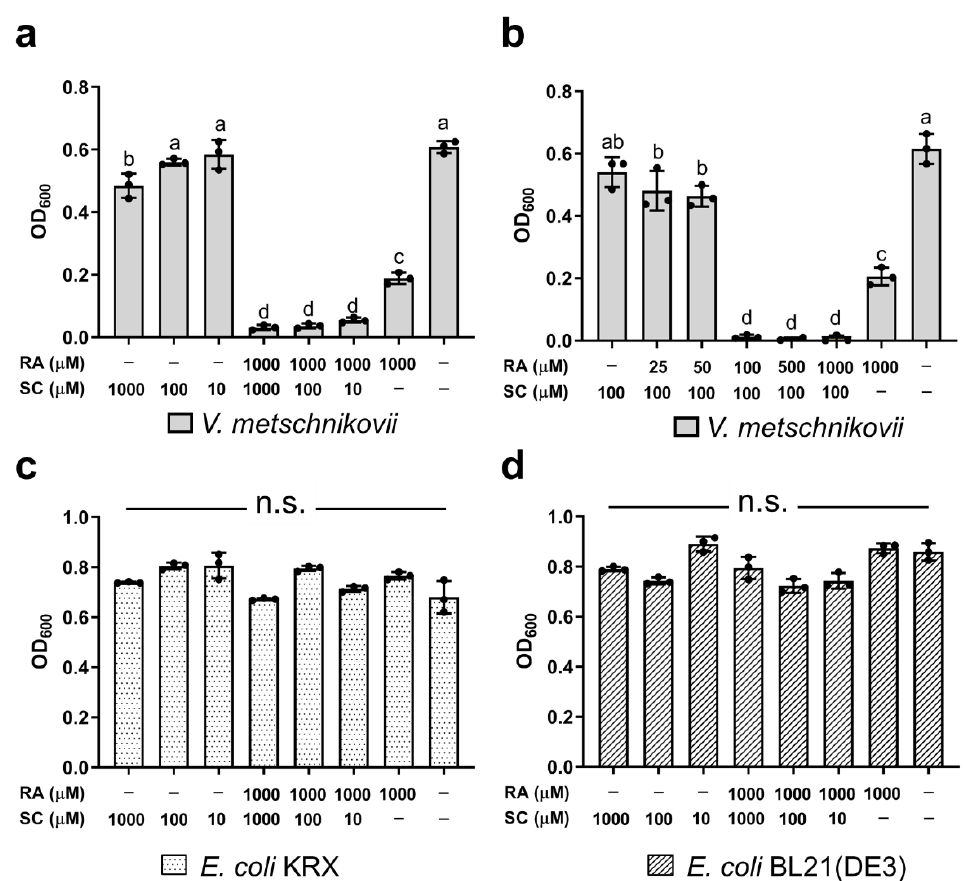
Figure 6. Antibacterial activity of the combination of RA and SC. ( a ) Dose-dependent effects of SC on V. metschnikovii inhibition with or without 1000 μM RA. ( b ) Dose-dependent effects of RA with 100 μM SC on V. metschnikovii inhibition. ( c ) Dose-dependent effects of SC on E. coli (KRX) inhibition with or without 1000 μM RA. ( d ) Dose-dependent effects of SC with or without 1000 μM RA on E. coli (BL21(DE3)) inhibition. Means with the same letter are not significantly different from each other ( p < 0.05). n.s. represents no significant difference.